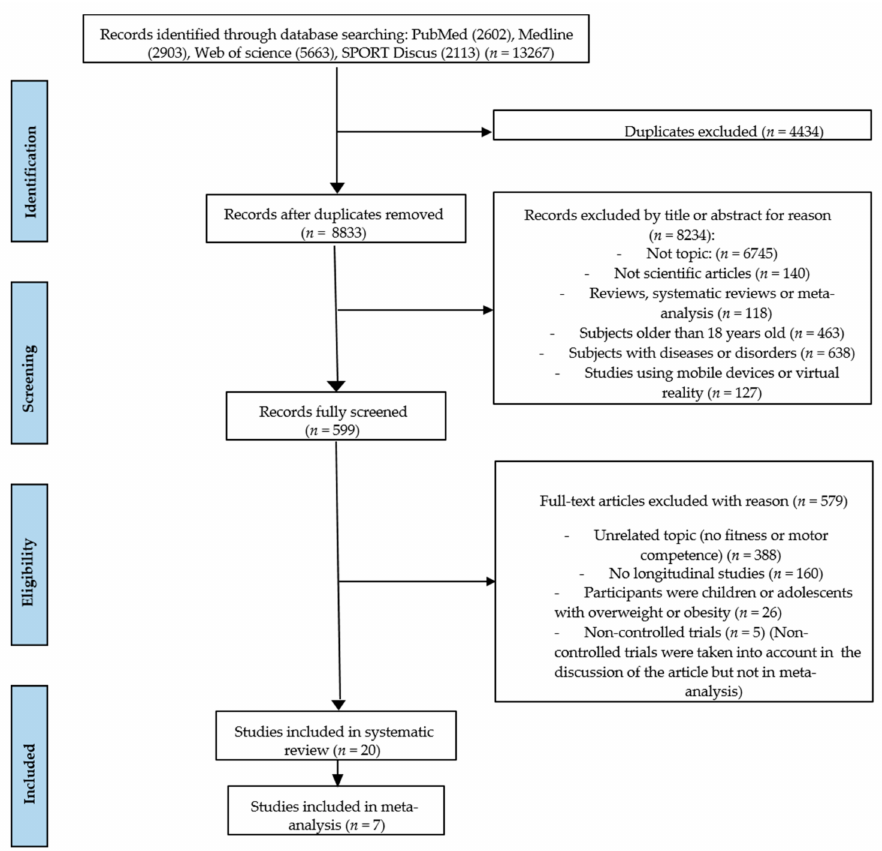
Figure 1. PRISMA flow diagram of articles that were